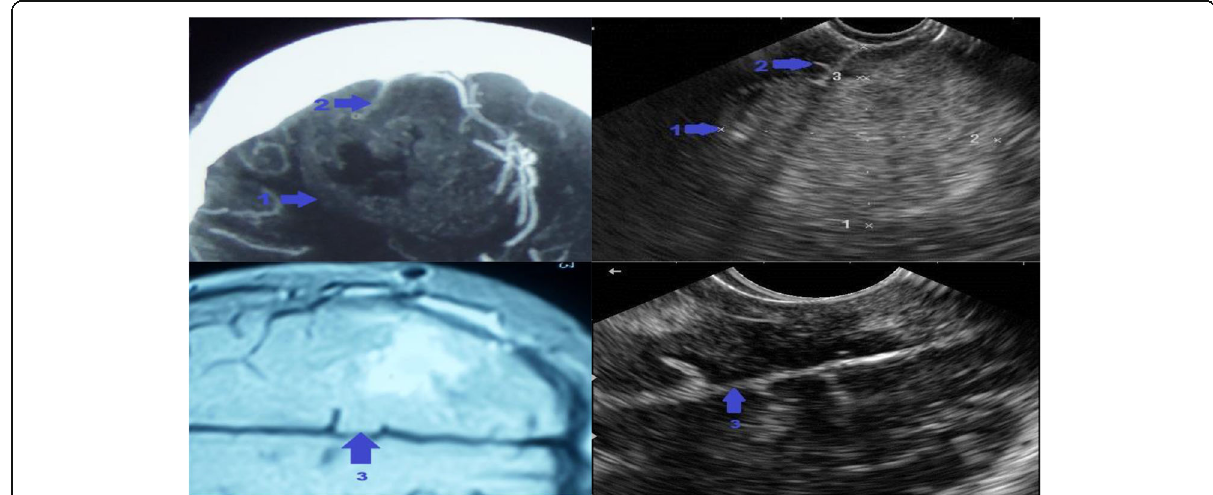
Fig. 5 Brain subarachnoid spaces; arrow1 brain mass lesion, arrow2 heterogeneous hyper-echogenic brain sulcus, arrow3 heterogeneous hyper- echogenic inter-hemispheric fissure and arrow4 heterogeneous hyper-echogenic